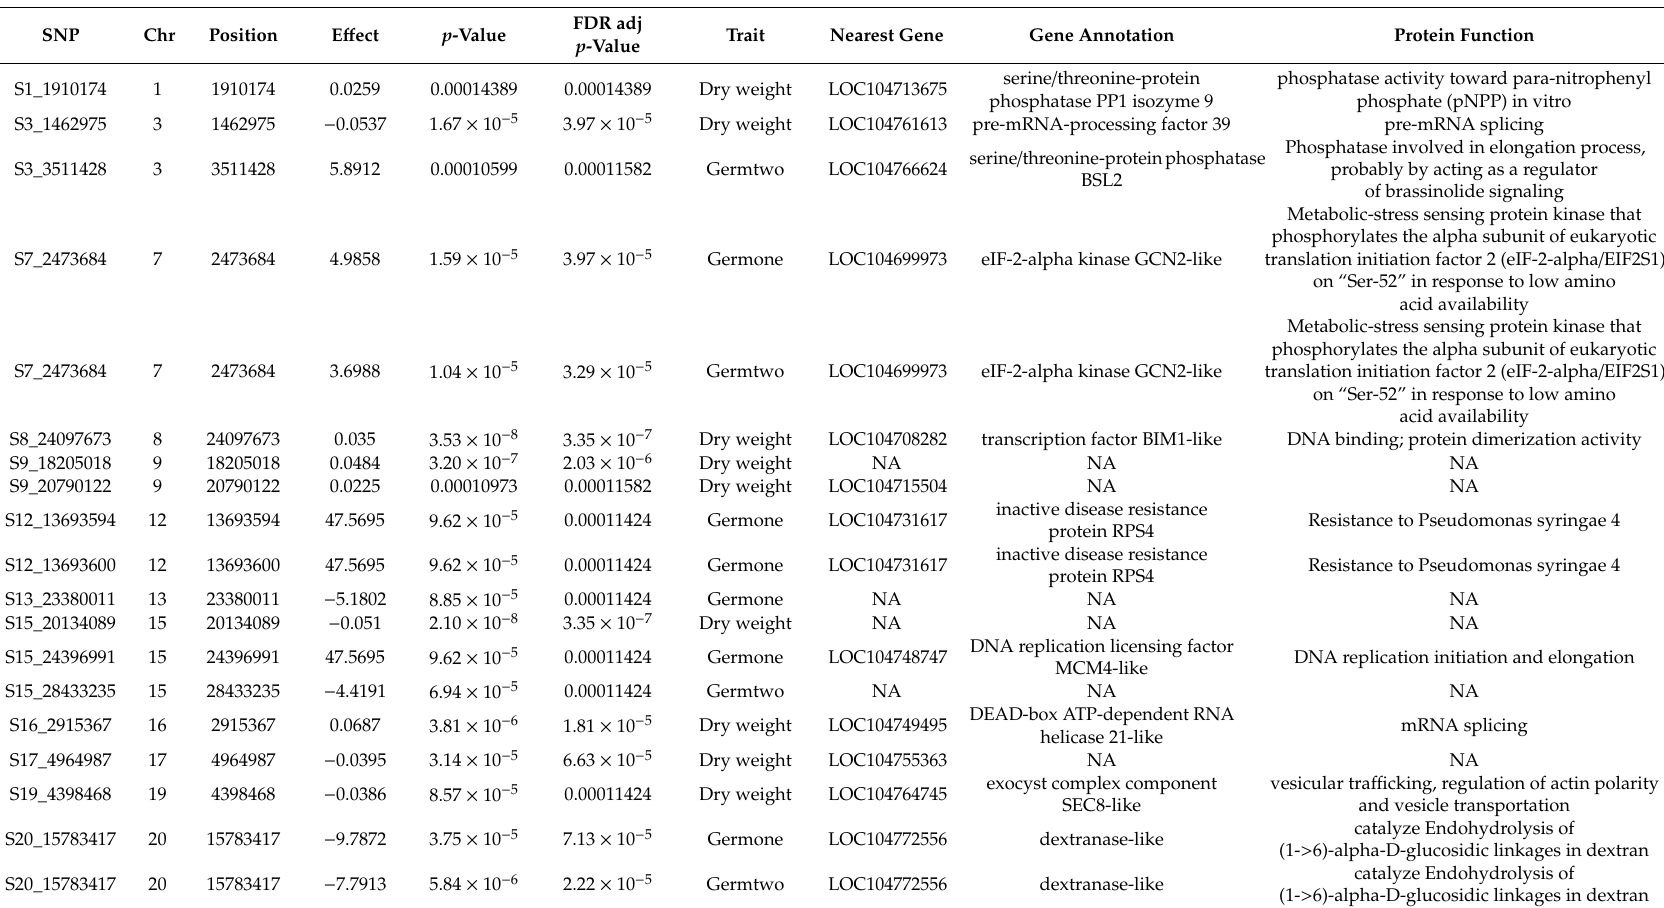
Table 4. Annotation of genes harboring significant trait-associated SNPs across 20 chromosomes in Camelina sativa under salt